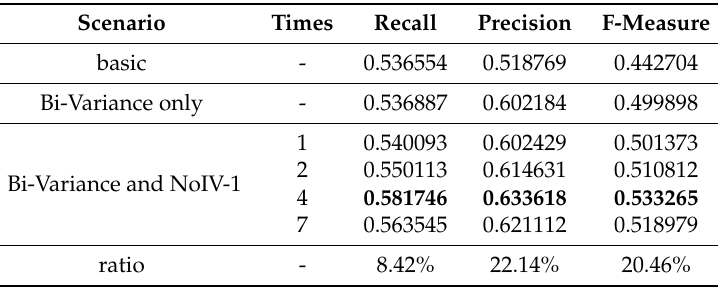
Table 2. Results of ViBeexecuted on three scenarios.